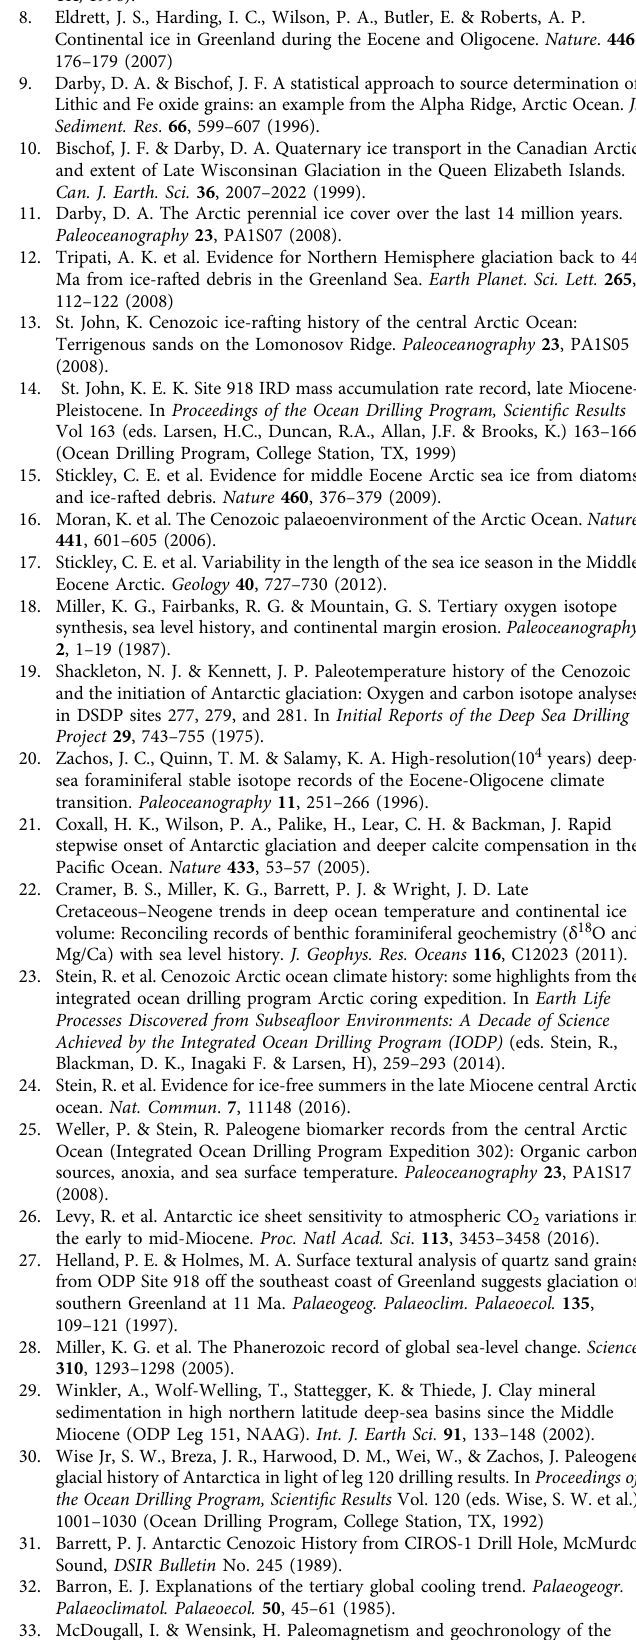
in Figs. 3 – 5, and as discussed in the text: (1) Site 913 (IRD provenance data generated in this study shown on the Site 913 age model) and (2) the ACEX site (full list of citations in Supplementary Methods). For ACEX, we note there are two different age models proposed 68,69 that yield different ages and place the fi rst appearance of IRD in ACEX a few million years apart, and produce different ice- rafting histories for that site. Therefore we show the results of using each of these age models in Fig. 3, with the different color lines in the bottom panel, as described in the fi gure caption. Comparison with ACEX IRD source matching . Estimates for number of ACEX IRD grains that can be matched to a source region comes from a publication 37 . Comparison with records of Arctic sea ice . Estimates for Arctic sea ice onset come from multiple publications. Full list of citations in Supplementary Methods. Site 913 IRD MAR . Estimates of IRD mass accumulation rates at Site 913 come from a publication 12 . Comparison with records of Antarctic ice . Estimates for Antarctic ice storage come from multiple publications. Full list of citations in Supplementary Methods. Composite deep-sea benthic foraminiferal δ 18 O and δ 13 C . Benthic foraminiferal δ 18 O and δ 13 C are a compilation from multiple publications. Full list of citations in Supplementary